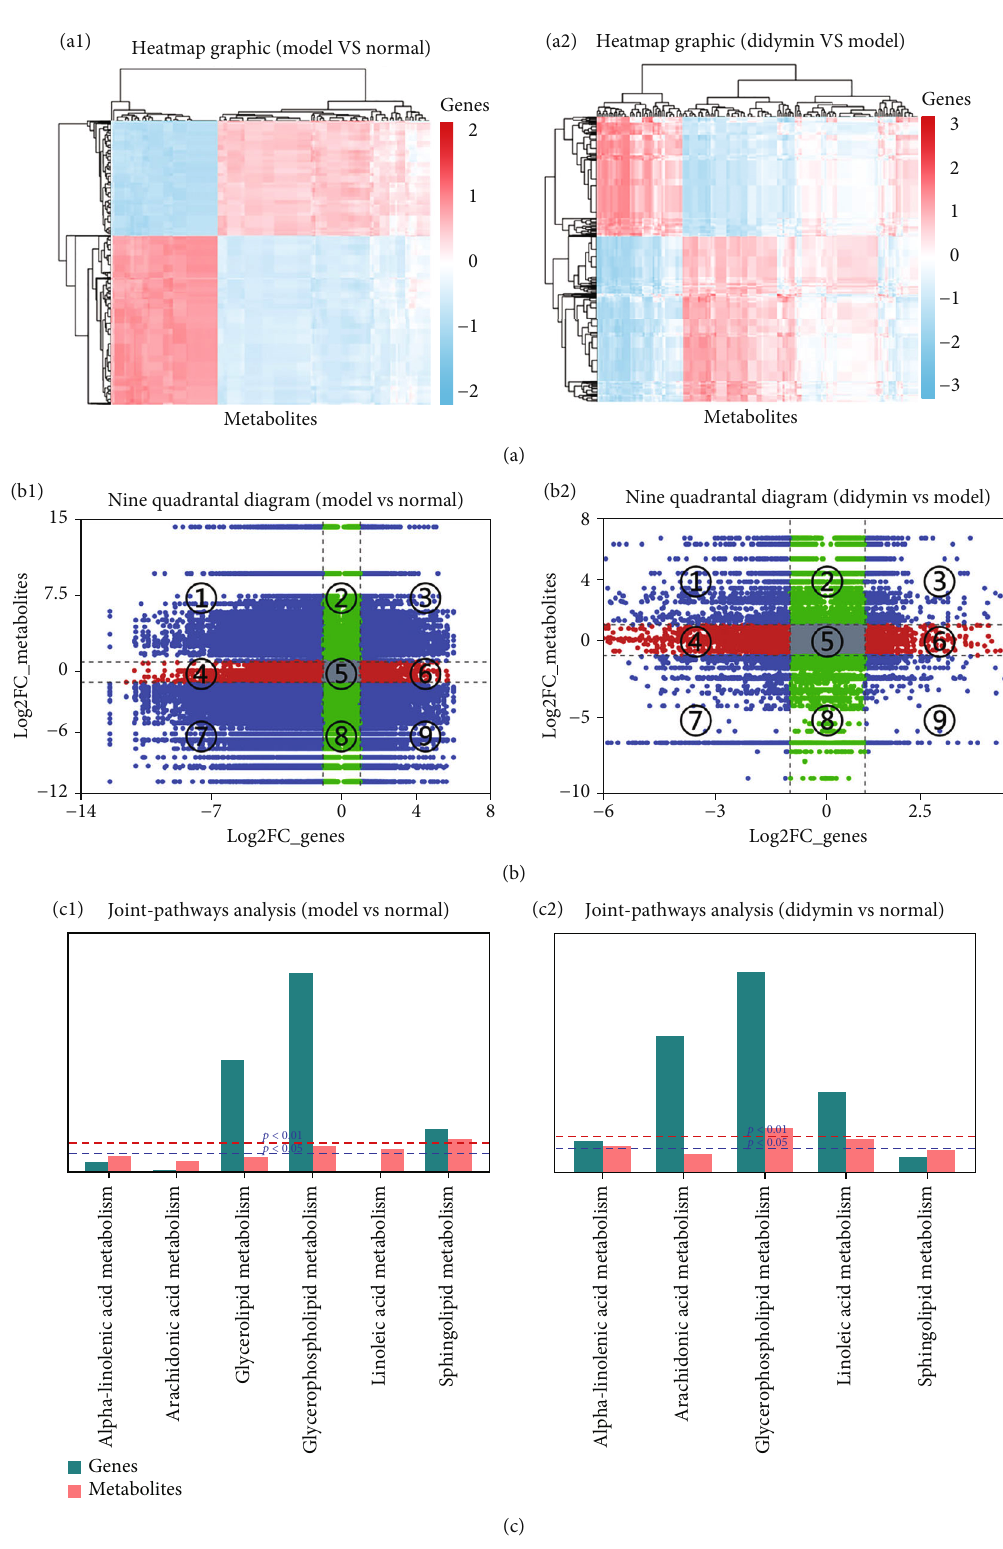
Figure 9: Correlation analysis of the transcriptome and metabolome. (a) The correlation heat map. (b) Nine quadrant diagram showing the correlation of genes and metabolites; the x -axis represents the log2 ratio of gene, and the y -axis represents the log2 ratio of metabolites; black-dotted lines represent the di ff erent thresholds. (c) KEGG enrichment analysis of the di ff erentially expressed genes (dark cyan column) and di ff erentially expressed metabolites (red column); the blue line represents the selected gene and metabolic pathway at p value < 0.05, and the red line represents the selected gene and metabolic pathway at P value <